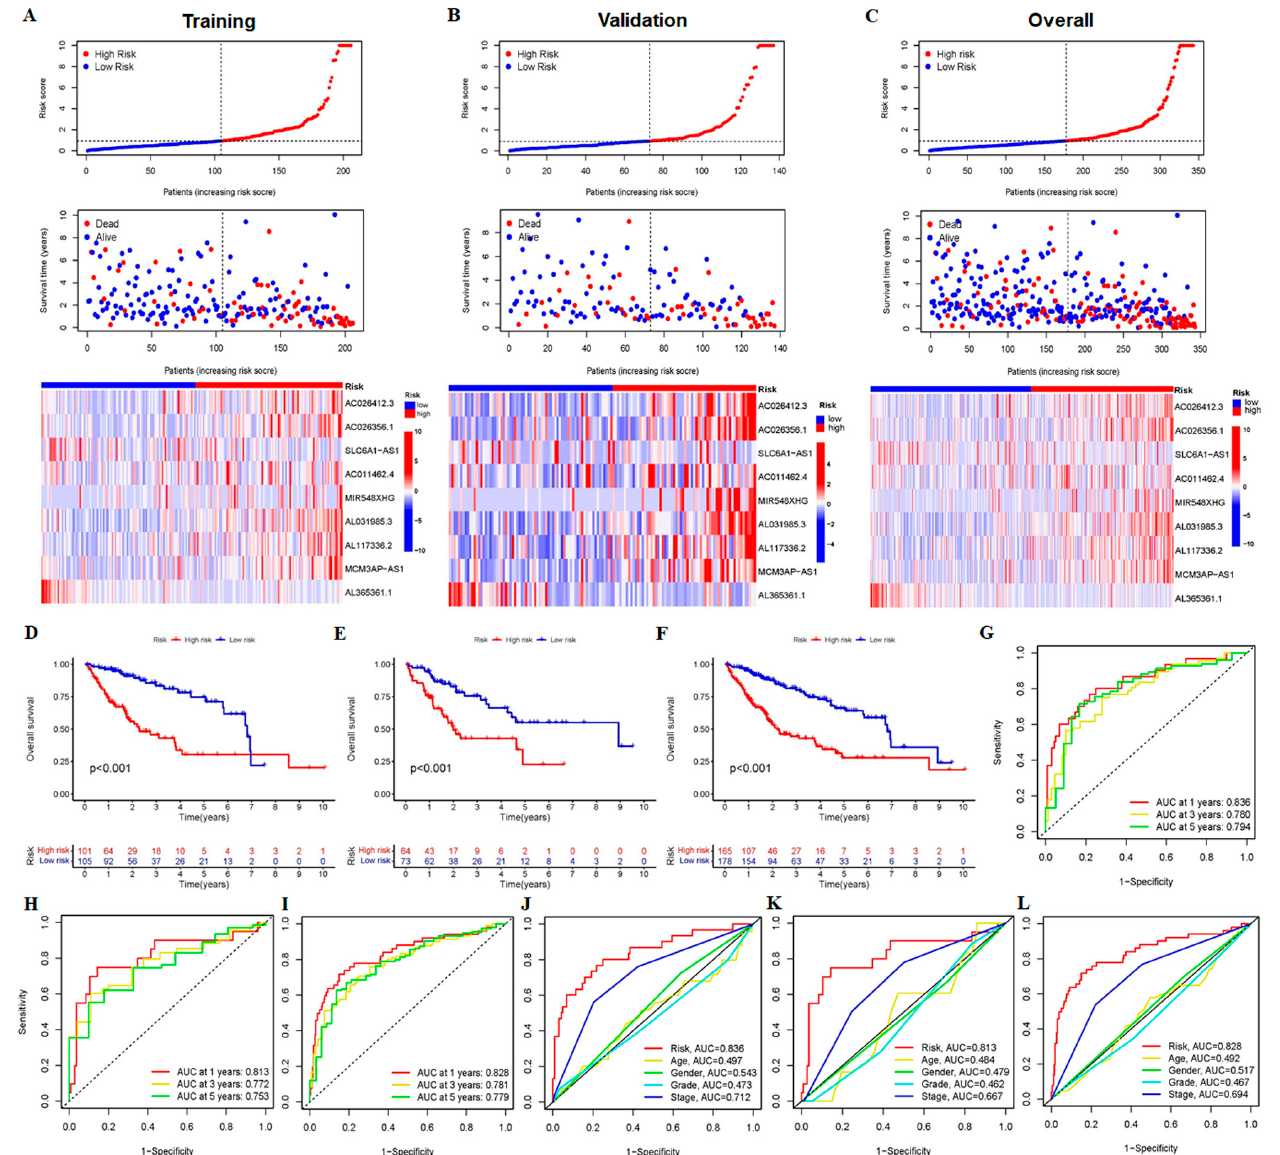
Figure 4. Validation of the 9-crLncRNA prognostic model in the training, validation and entire groups. The training group was further divided into the high-risk group (101 cases) and the low-risk group (105 cases) based on the median risk score. The validation sample was then divided into the high-risk group (64 cases) and the low-risk group (73 cases). Each sub-graph of Figure 4 shows the risk score curves, survival status distribution maps, the 9-crLncRNA expression heatmaps ( A – C ), Kaplan–Meier survival curves ( D – F ), the ROC curves of the overall survival at years 1, 3, and 5 ( G – I ), and the ROC curves of the risk score and other relevant clinical characteristics of the 9-crLncRNA ( J – L ) for the training, validation and entire groups, respectively. p < 0.05 was considered statistically significant.